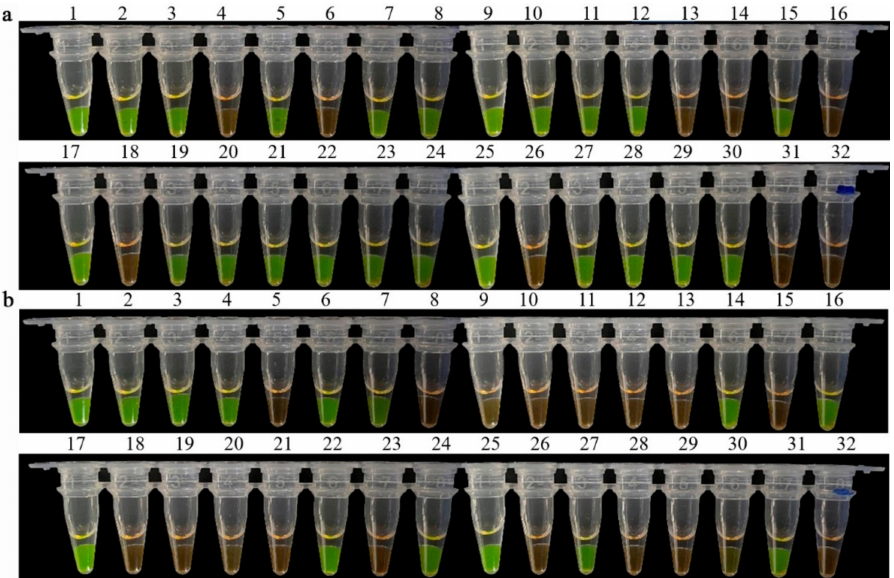
Figure 12. Loop-mediated isothermal amplification (LAMP) detection of P. graminea in barley seeds from naturally infected fields. Assessment based on SYBR Green I visualization of color change. Profiles in ( a ) are LAMP products with DNA from barley seeds of cultivar 1141, and profiles in ( b ) are those from cultivar BDM02-3. Tube 1, reaction with genomic DNA from P. graminea (positive control); tubes 2 to 31, reactions with DNA from naturally infected single barley seeds; tube 32, reaction with sterile ddH 2 O (negative